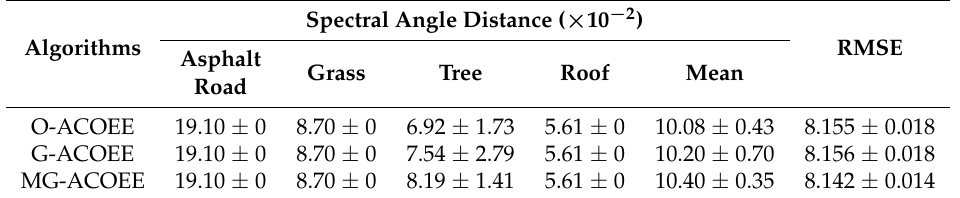
Table 4. Comparison of O-ACOEE, G-ACOEE, and MG-ACOEE (ASC) on endmember extraction accuracy for Urban data.